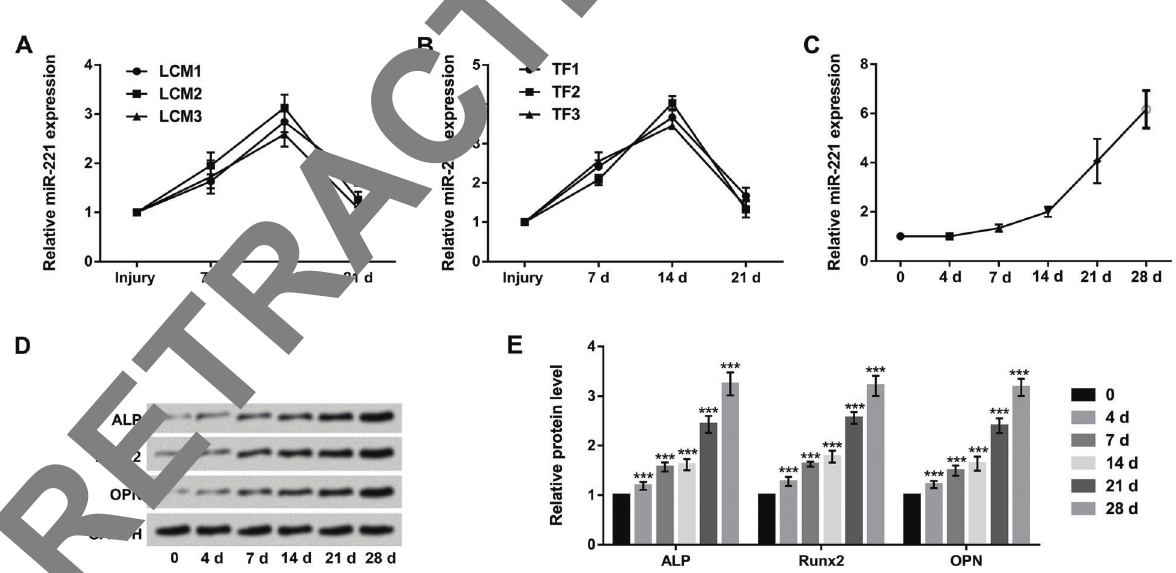
Figure 1. miR-221 is up-regulated during the osteoblast differentiation process. A and B , Blood concentrations of miR-221 in three lumbar compression fracture (LCM) patients and three trochanteric fracture (TF) patients were examined by qRT-PCR. Then, MC3T3-E1 cells were treated with osteogenic differentiation media. C , Expression of miR-221 during osteoblast differentiation at 0, 4, 7, 14, 21, and 28 days was detected by qRT-PCR. D and E , Protein levels of ALP, Runx2, and OPN were assessed by western blot. miR -221: microRNA-221; qRT-PCR: quantitative reverse transcription polymerase chain reaction; ALP: alkaline phosphatase; Runx2: runt-related transcription factor 2; OPN: osteopontin. Data are reported as means ± SD. ***P o 0.001 compared to baseline